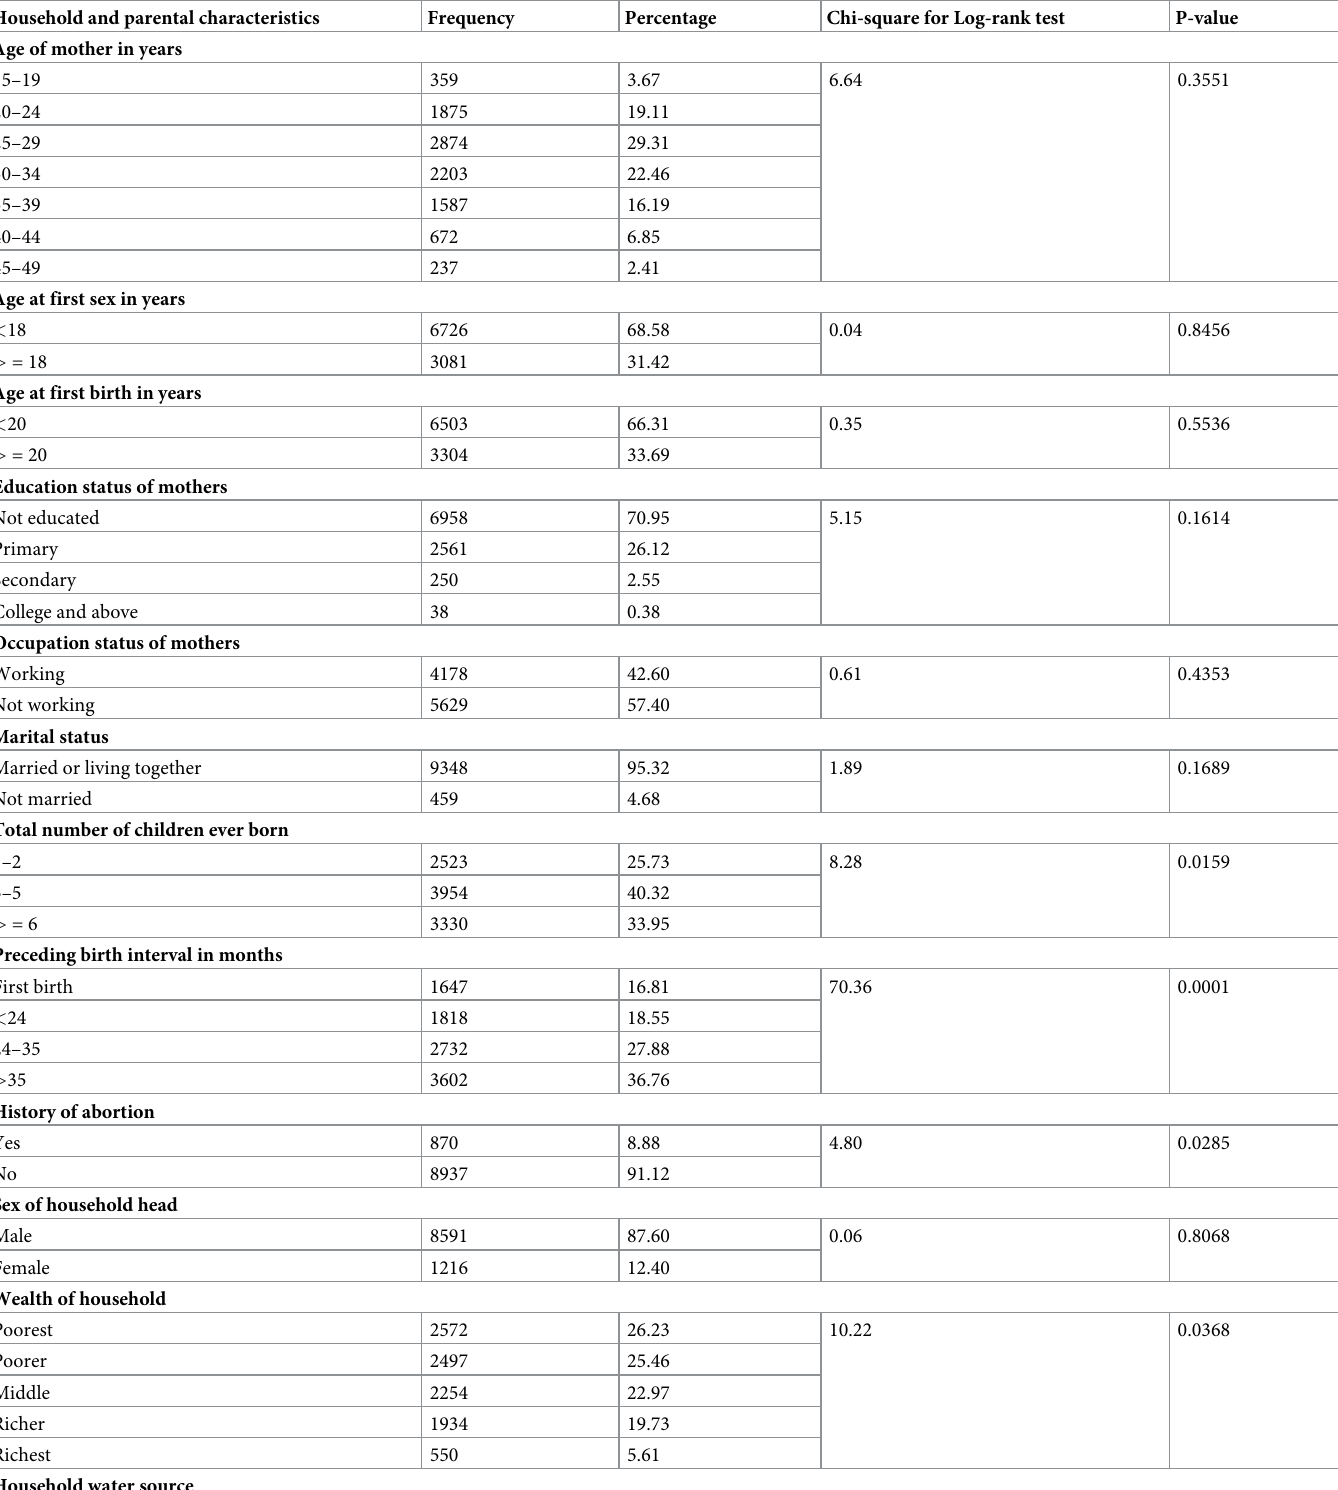
Table 1. Household and parental characteristics of under-five children in rural Ethiopia based on the 2016